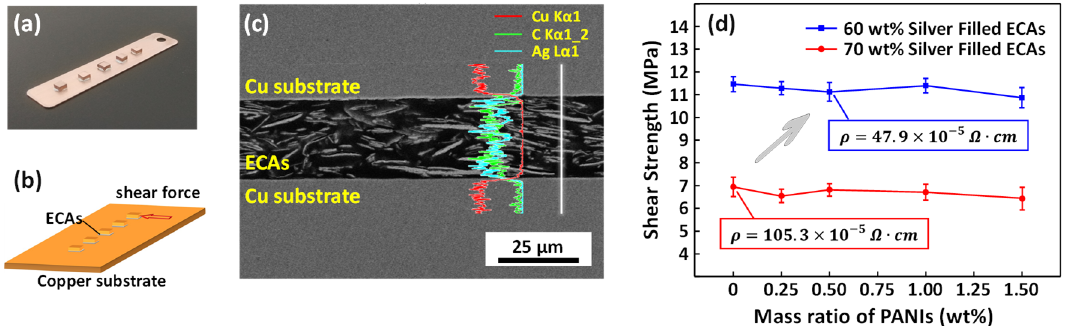
Figure 4. Photograph ( a ) and schematic diagram ( b ) of Cu / ECAs or PECAs / Cu sandwich structure for shearing test; ( c ) The cross section of Cu / PECAs / Cu bonding joint and EDS line scan corresponding to the write line; ( d ) dependence of the shear strength of ECAs joint on the amount of adding PANIs.